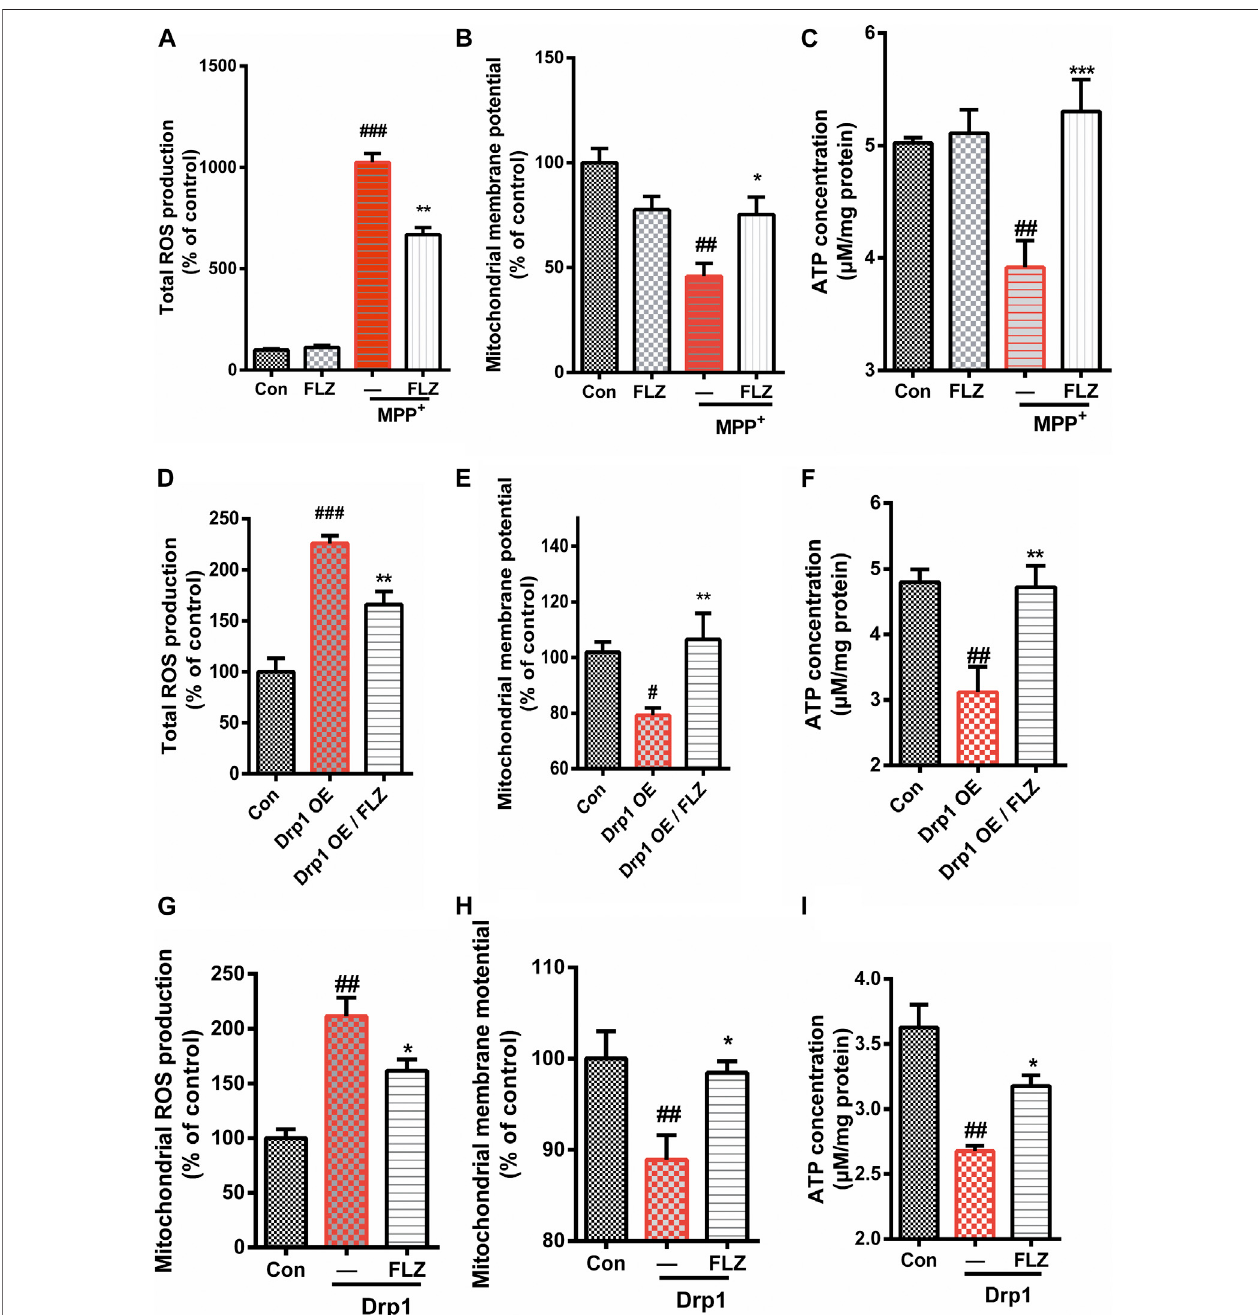
FIGURE 5 | FLZ treatment reduced mitochondrial dysfunction. Cultured SH-SY5Y cells were treated with FLZ (10 μ M) for 30 min followed by incubation with or withoutMPP + (2 mM)for6 h.Levelsof (A) TotalROSexpression (B) Mitochondrialmembranepotential, (C) ATPconcentrationweremeasured.CulturedHelacellswere transfected with a plasmid encoded Drp1 protein for 24 h and then the cells were incubated with FLZ for 24 h. Levels of (D) Total ROS expression, (E) Mitochondrial membranepotential, (F) ATPconcentrationweremeasured.ToevaluatedthedirecteffectsofactivatedDrp1onthemitochondria,weincubatedDrp1recombinant proteinwithisolatedmouse livermitochondria.Levelsof (G) TotalROSexpression, (H) Mitochondrialmembranepotential concentration and (I) ATPconcentrationwere measured.ThedataoftotalROSexpressionandmitochondrialmembranepotentialarepresentedaspercentagechangerelativetothecontrolgroup. n (cid:2) 4 ∼ 6.One-way ANOVAfollowedbyTukeyposthoccomparisons testswereperformedinallstatisticalanalyses. ## p < 0.01and ### p < 0.001vs.Controlgroup, * p < 0.05and ** p < 0.01 vs. MPP + treated